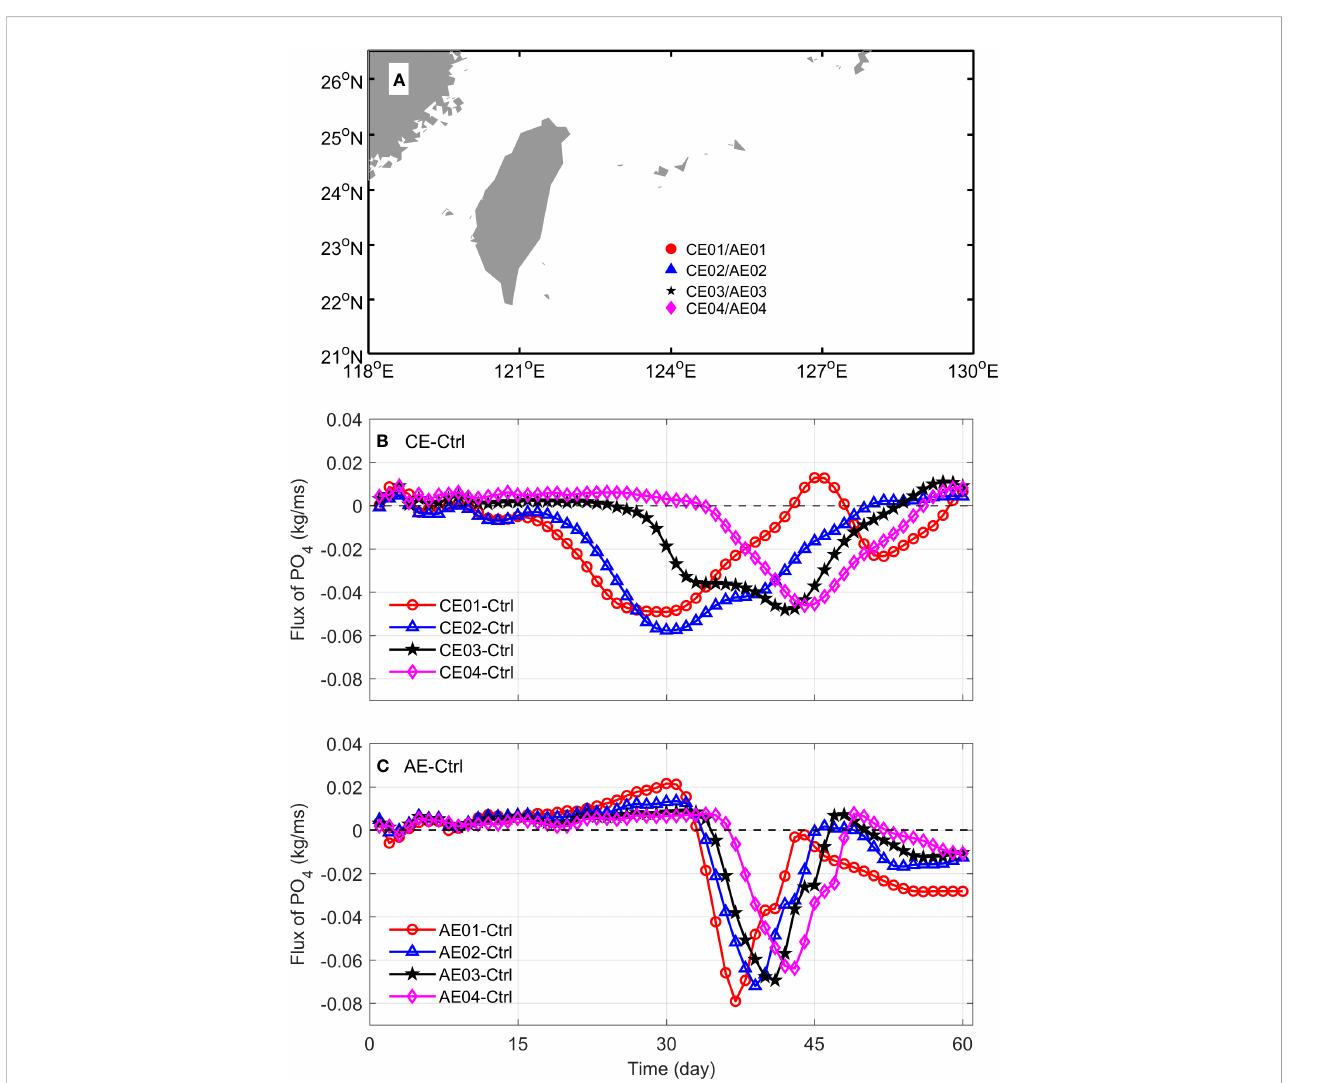
FIGURE 14 The (A) initial location of eddies for different experiments and (B, C) time series of differences in volume-averaged cross-shelf phosphate fl ux west of 124.17°E between the eddy experiments and control